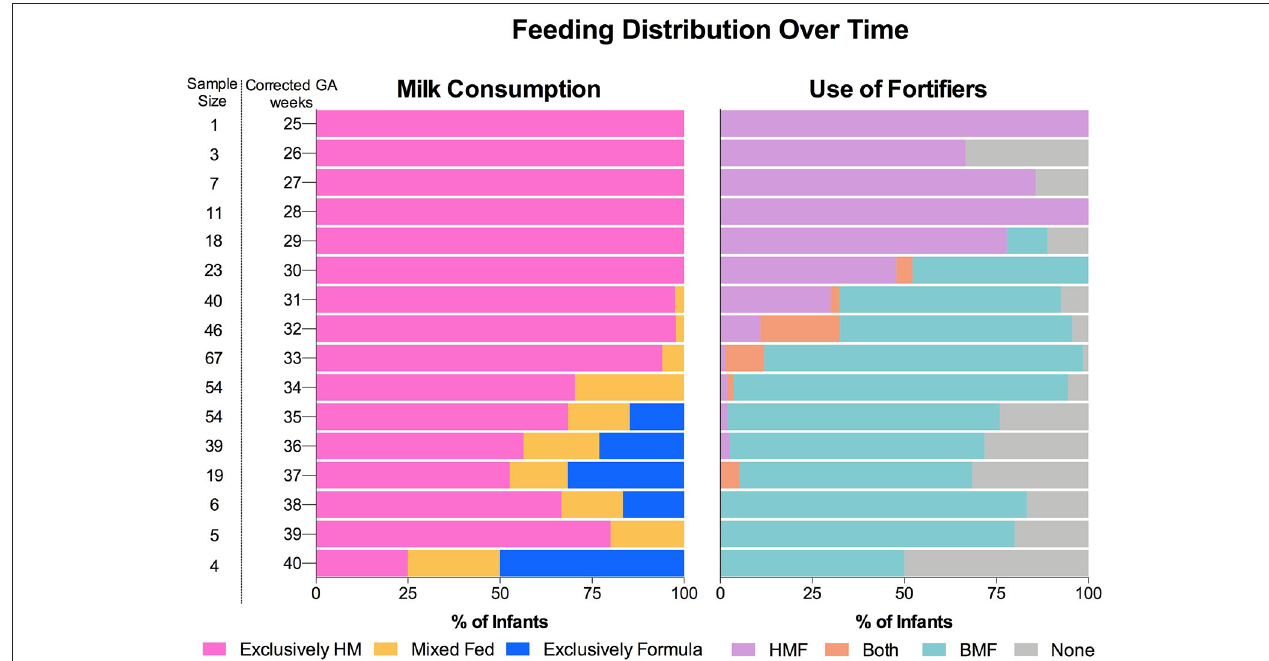
FIGURE 1 | Feeding distribution of preterm infants during hospitalization period at the neonatal intensive care unit. Consumption of milk and use of fortifiers over time. Human milk and the use of a BMF was the most common regimen. HM, Human milk; HMF, human milk-based fortifier; BMF, bovine milk-based fortifier.